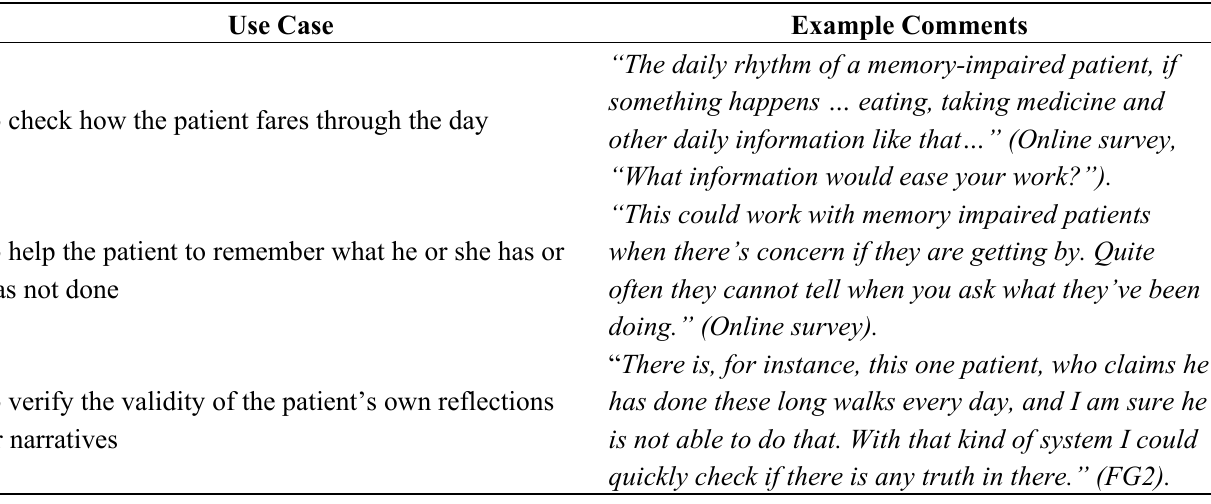
Table 2. Key use cases for the 3D visualization-based activity recognition system.